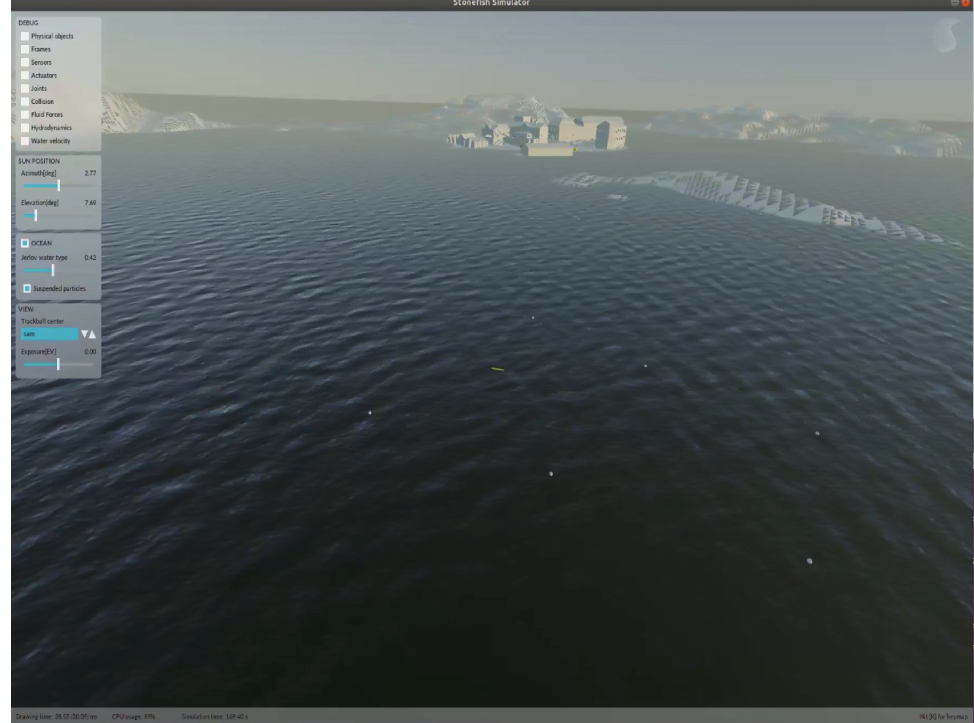
Figure 12. The numerical model (white buoys) seen from the surface of the seaweed farm in the simulator. The SAM AUV (yellow small AUV in the middle of the fig) can also be seen